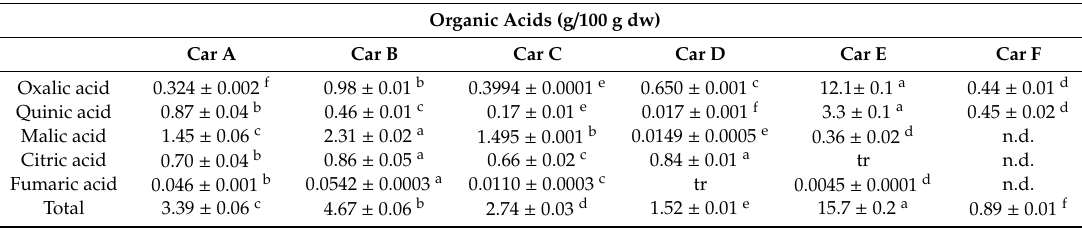
Table 3. Organic acids composition (g / 100 g dw) of Cynara cardunculus heads in relation to maturity stage (mean ± SD; n = 3).